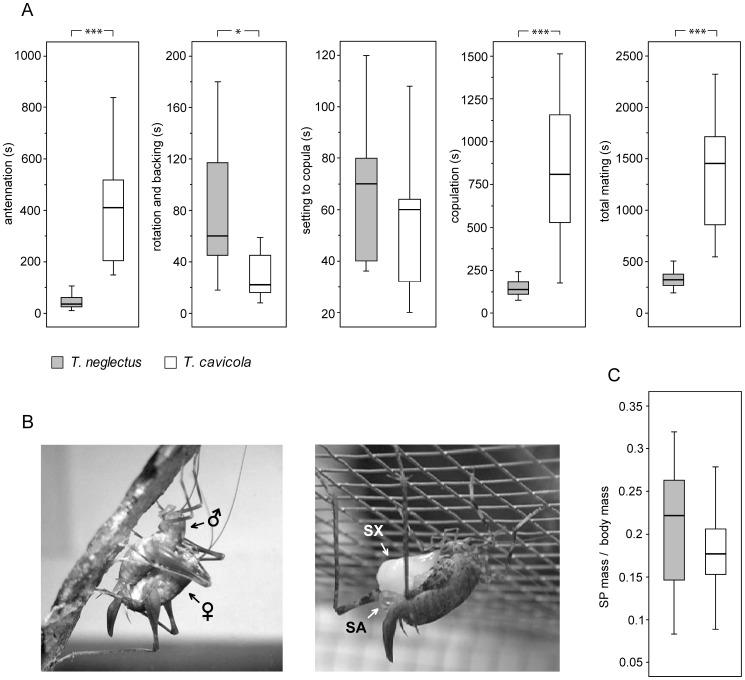
The mating process.A. Duration of successive mating phases and total mating time of Troglophilus neglectus and T. cavicola (box-whiskers plot with median and interquartile ranges, outliers excluded; the legend is the same for A and C). The asterisks indicate the degree of significance in T-test (* P<0.05, *** P<0.001). T-test values: antennation t
12.305 = −6.425, P<0.001; rotation and backing t
28 = 2.115, P = 0.043; setting to copula t
28 = 1.395, P = 0.174; copulation t
19.317 = −6.816, P<0.001, total mating t
13.367 = −6.180, P<0.001. B. A photograph of T. cavicola pair in copula (left) and of a female T. neglectus feeding on a spermatophore (right; SA − sperm ampula, SX − spermatophylax). C. The spermatophore (SP) mass as a proportion of the body mass compared between the species (T-test values: t
21 = 0.936, P = 0.360).